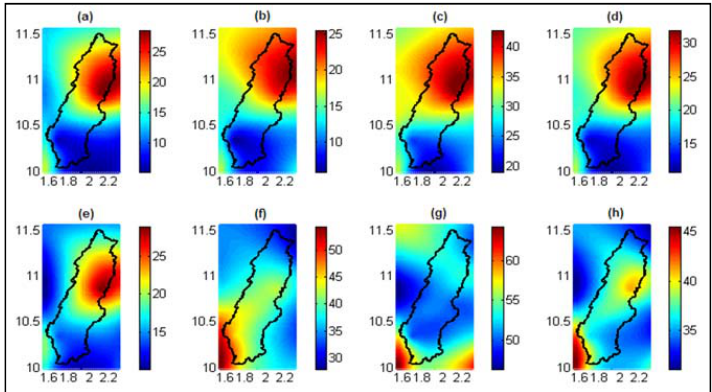
Figure 12 : Changes in the maximum precipitation amounts during 48 consecutive hours (%) Figure 12. Changes in the maximum precipitation amounts during 48 consecutive hours (%) compared to the reference period: a : RCP4.5-2011–2040; b : RCP4.5-2041–2070; c :